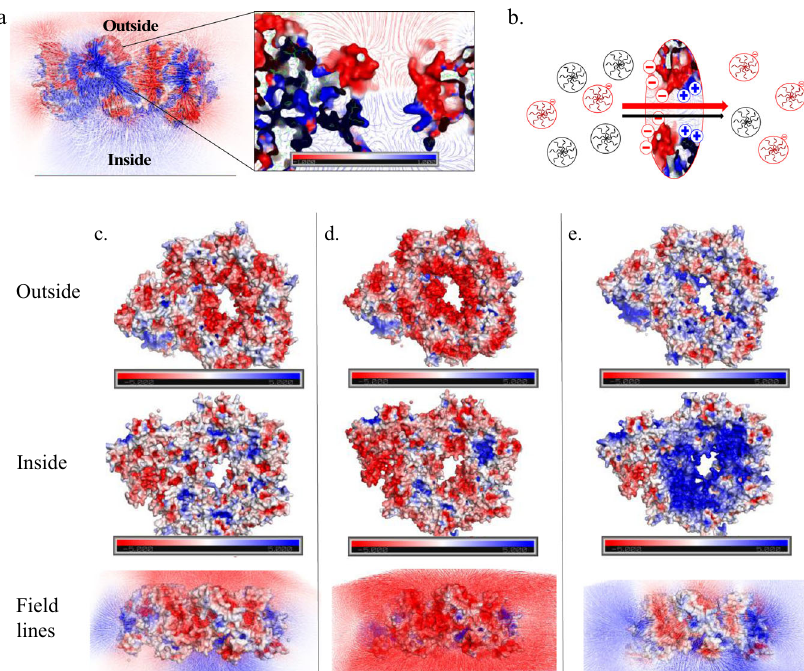
Fig. 6 Electrostatic maps of P22 pores. a Electrostatic surface potential of the wtP22 PC asymmetric unit with electric fi eld lines with negative and positive surface potential in red and blue, respectively. Maximum and minimum units are 1 to − 1 kT/e. b Cartoon of dendrimers diffusing across the P22 pore. c , d Comparison of P22 CP electrostatic surface outside (top), inside (middle), and fi eld lines (bottom) for c wt, d K184Q/R203S, and e